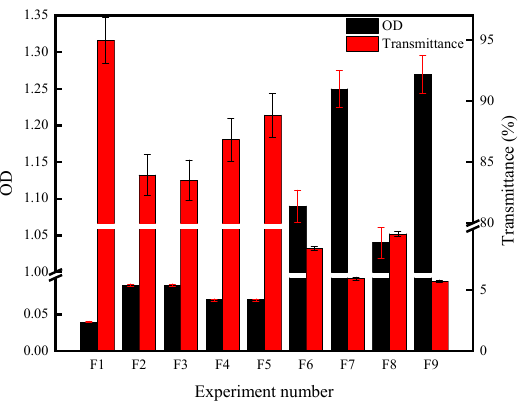
Figure 7. Test results of optical density and transmittance of pure and of functional PU films.